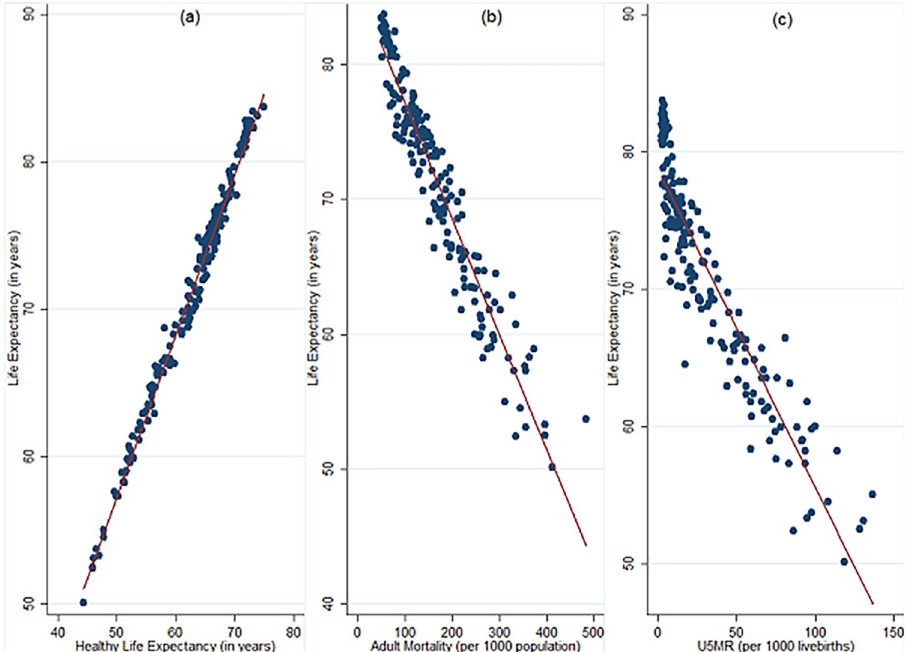
Fig 2. Relationship between life expectancy and other indicators of population health. a) LE vs HALE b) LE vs AMR c) LE vs U5MR. LE: Life Expectancy at birth (in years), HALE: Healthy Life Expectancy (at birth), AMR: Adult Mortality Rate (per 1000 population) and U5MR: Under-5 mortality Rate (per 1000 livebirths). The data pertains to 183 countries in 2015 and is procured from WHO mortality and global health estimates